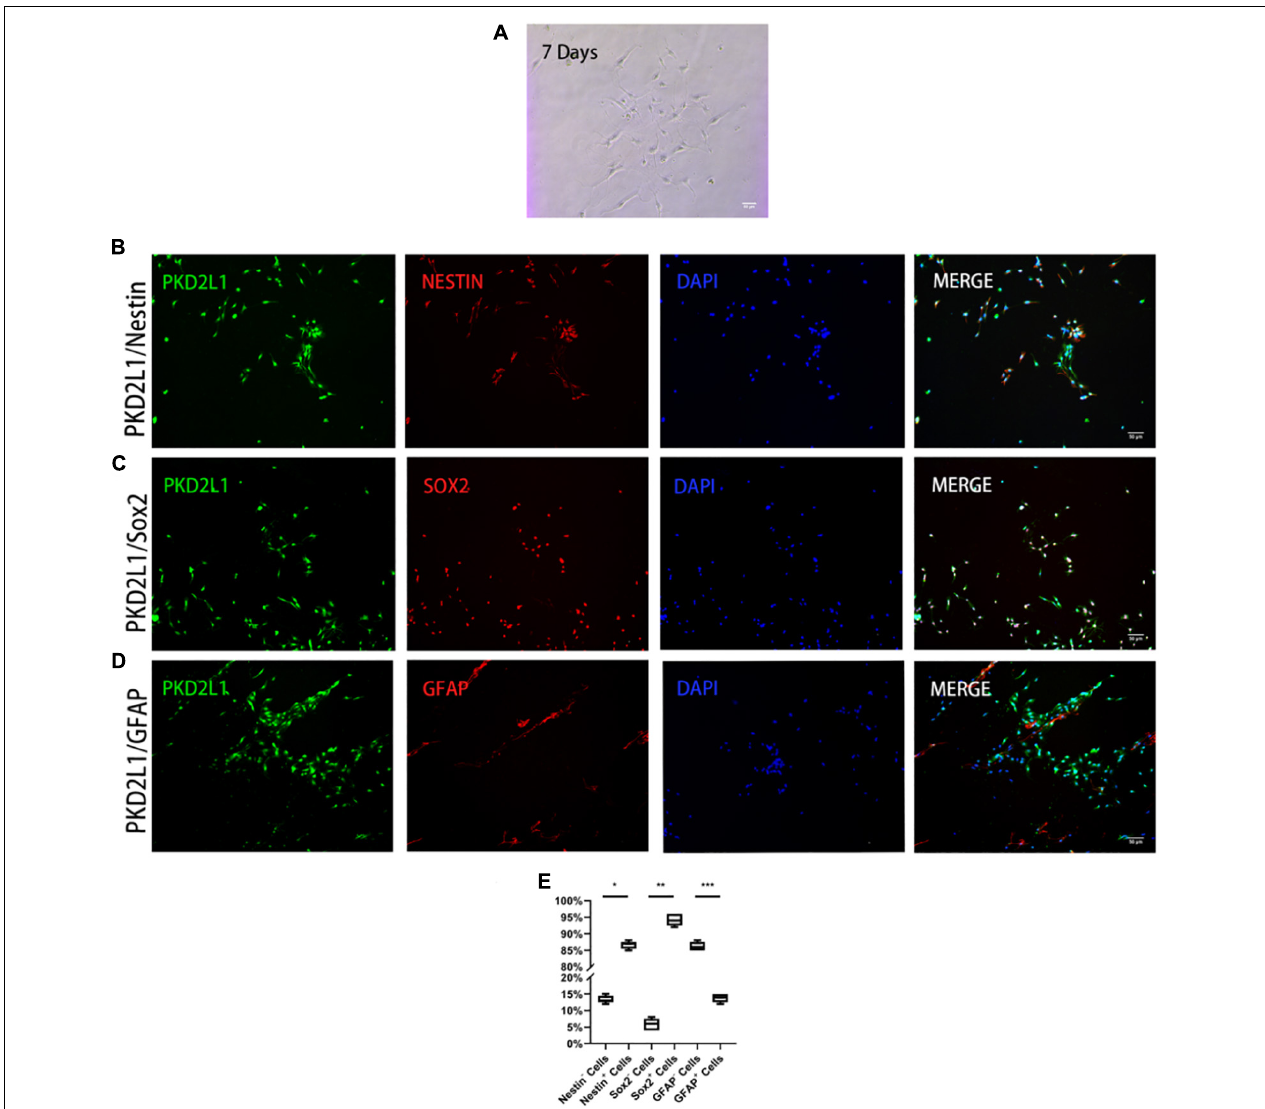
FIGURE 2 | CSF-cNs expressed neural stem cell markers. (A) FACS-isolated CSF-cNs were cultured for 7 days. (B–D) Immunofluorescence analysis showing that FACS-isolated CSF-cNs expressed neural stem cell markers for nestin (B) , Sox2 (C) , and GFAP (D) . (E) The ratios of nestin + /nestin - cells, Sox2 + /Sox2 - cells, and GFAP + cells/GFAP - cells, respectively. * P < 0.05 compared to nestin - cells group. ** P < 0.05 compared to Sox2-cells group. *** P < 0.05 compared to GFAP - cells